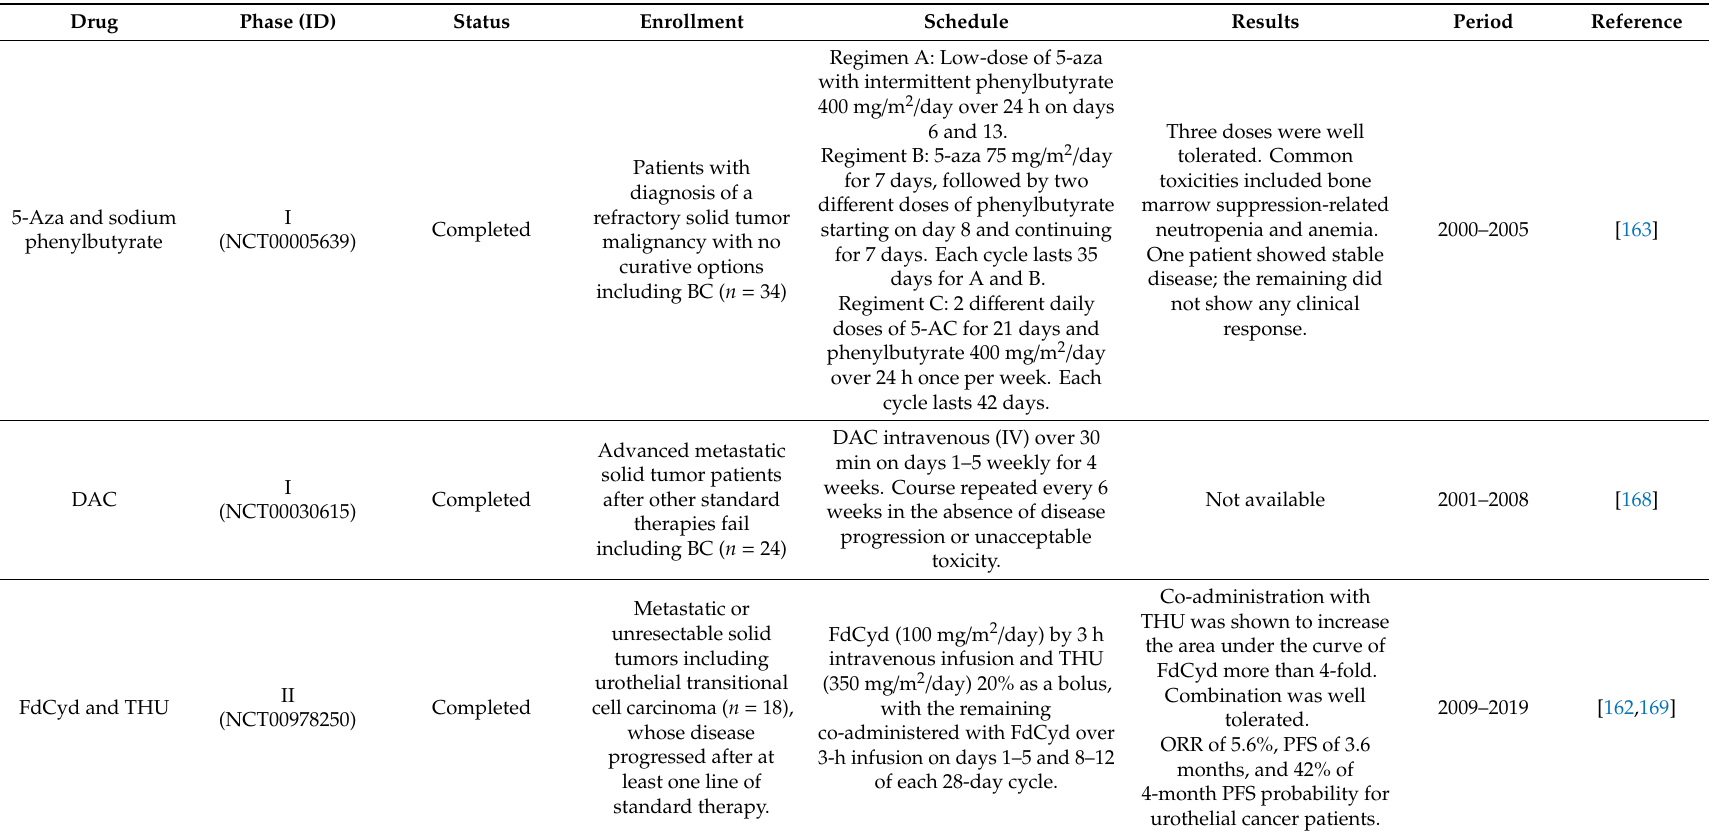
Table 3. Clinical trials in BC using DNMT